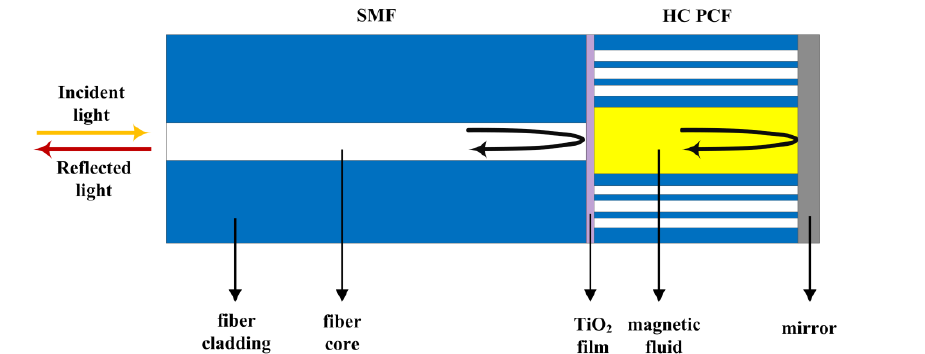
Figure 16. Structure diagram of magnetic fi lled HC PCF FP sensor proposed by Zhao et al . [83].